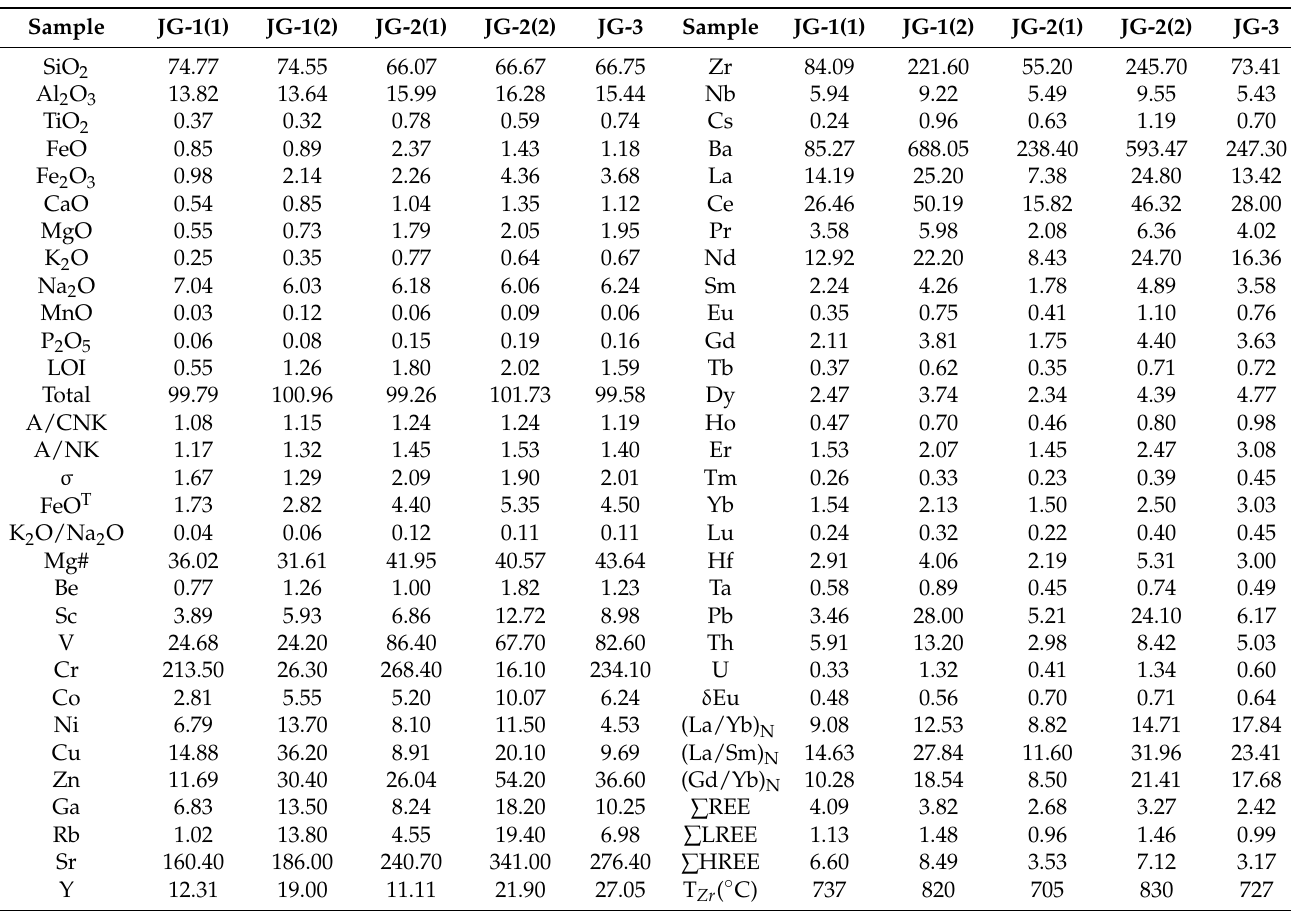
Table 2. Sr–Nd isotopic data for the Late Permian granitic pebble samples from the Jin ′ gui Island. t(Ma) Sample